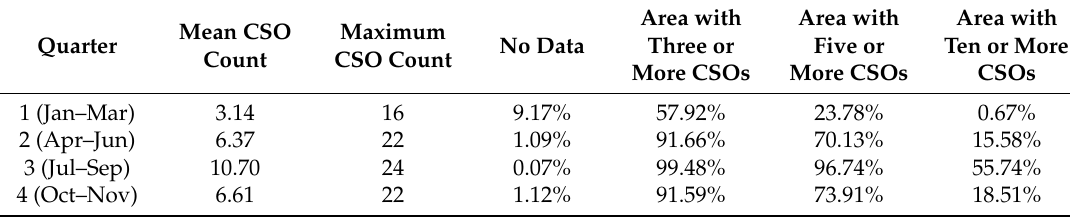
Figure 1. Study area and clear-sky observation count for 2015. Overlay represents the 63 Landsat WRS-2 scenes covering Turkey. Table 3. Landsat clear sky observation statistics for Turkey, 2015.